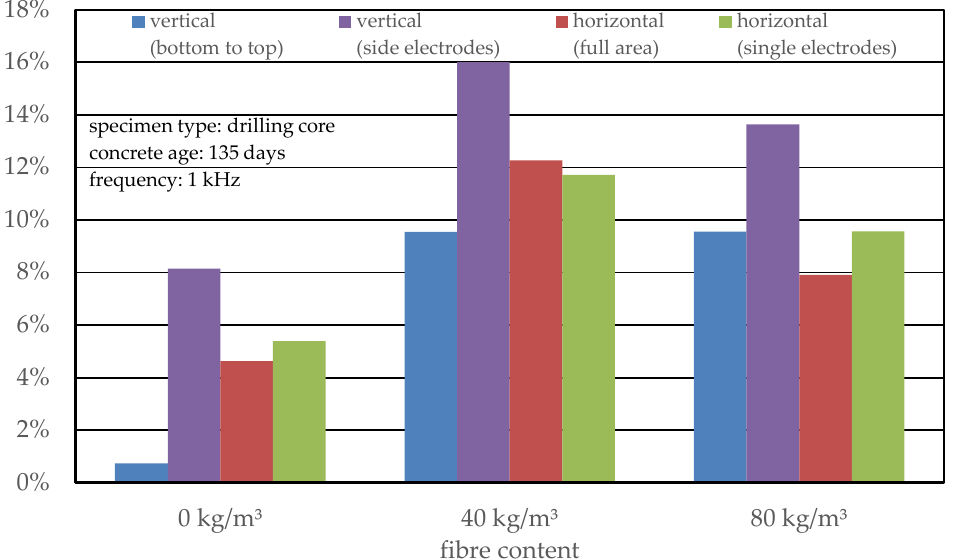
Figure 13. Coefficient of variation of the calculated electrical resistivity of drilling cores depending on the fibre content.